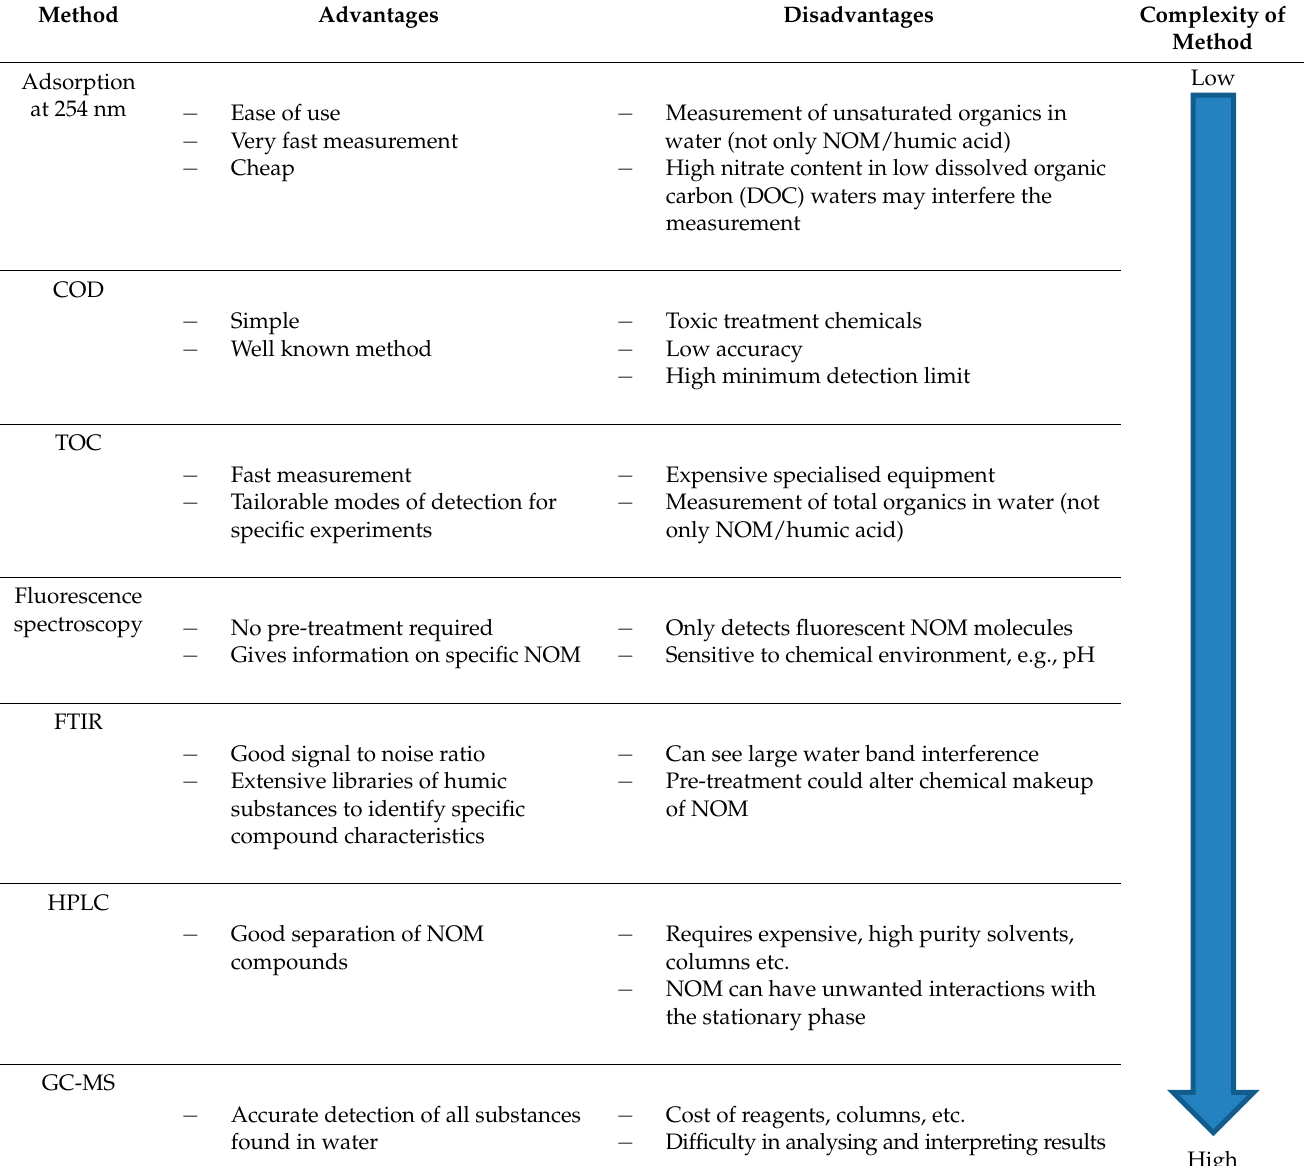
Table 1. Table presenting the main analytical techniques for natural organic matter (NOM) detection and quantification in water.